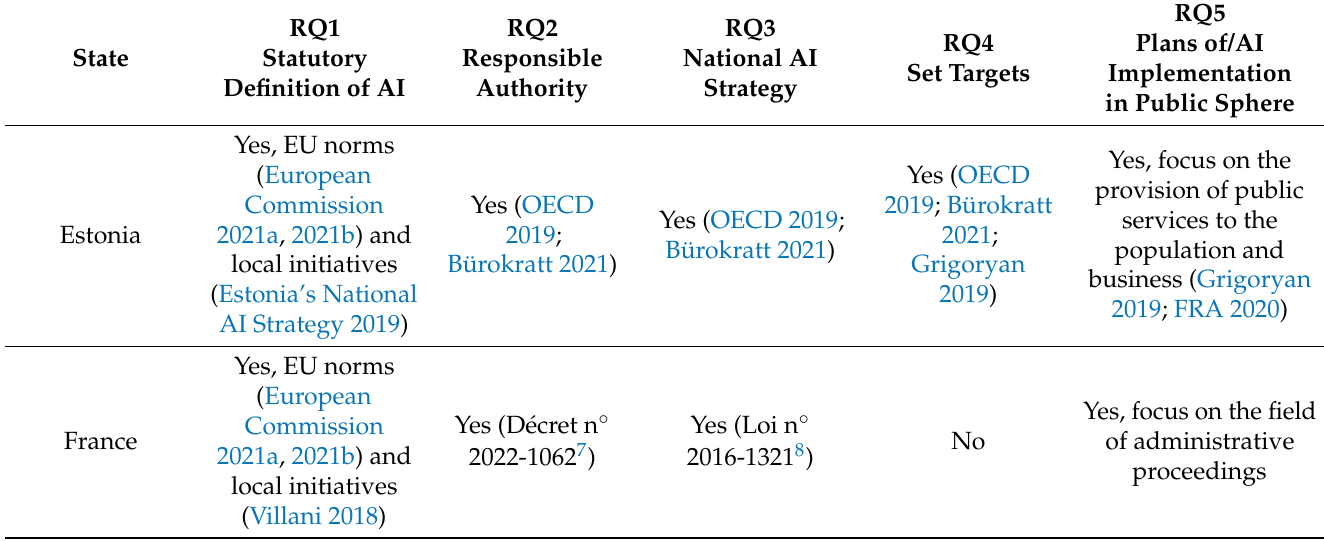
Table 1. Comparative analysis of national strategies in the field of AI in the leading countries of the Romano-Germanic legal system (compiled by the